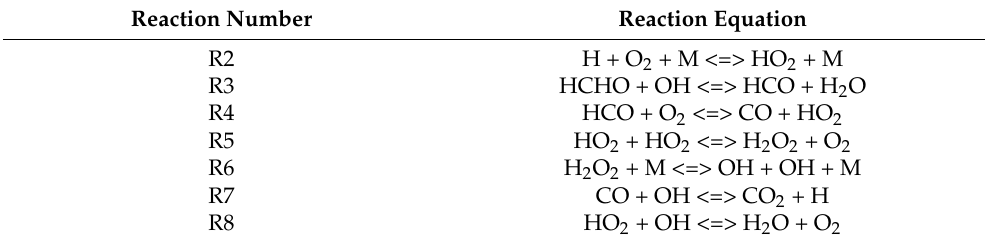
Figure 12. Heat release rate for various important elementary reactions at T c = 650 K, P c = 20 bar, and ϕ = 0.4: ( a ) R2, R7, R8; ( b ) R3, R4; and ( c ) R5, R6. Table 3. Important elementary reactions contributing to the heat release rate .